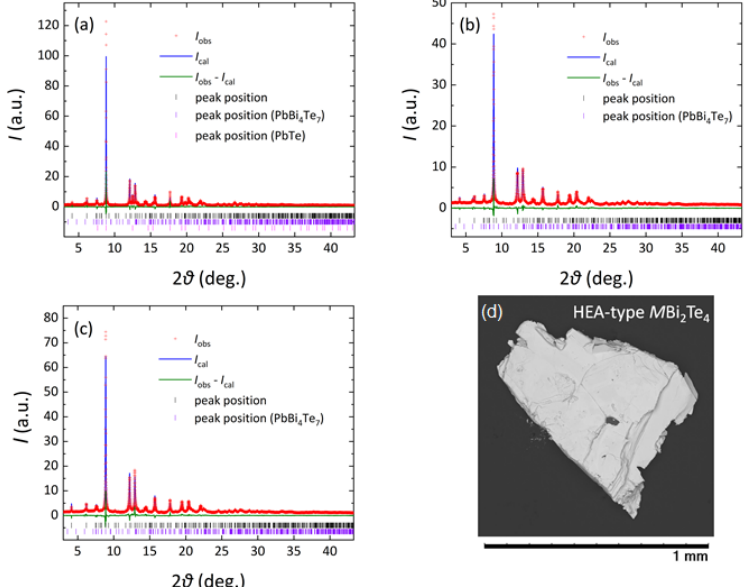
Figure 1. Rietveld profile fitting results for M Bi 2 Te 4 : ( a ) PbBi 2 Te 4 ( d -spacing range; d > 0.67 Å ), ( b ) MEA ( d > 0.66 Å ), and ( c ) HEA ( d > 0.67 Å ). The red dots show the measured data ( I obs ), and the blue lines are the fitted profiles ( I cal ). The green line is the difference curve ( I obs - I cal ), and the black, violet and pink ticks are the peak positions for the main phase ( M Bi 2 Te 4 ) and the impurity of PbBi 4 Te 7 and PbTe. The PbBi 2 Te 4 sample included PbBi 4 Te 7 (21%) and PbTe (13%). The MEA sample included PbBi 4 Te 7 (38%). The HEA sample included PbBi 4 Te 7 (16%). ( d ) SEM image of the HEA sample.